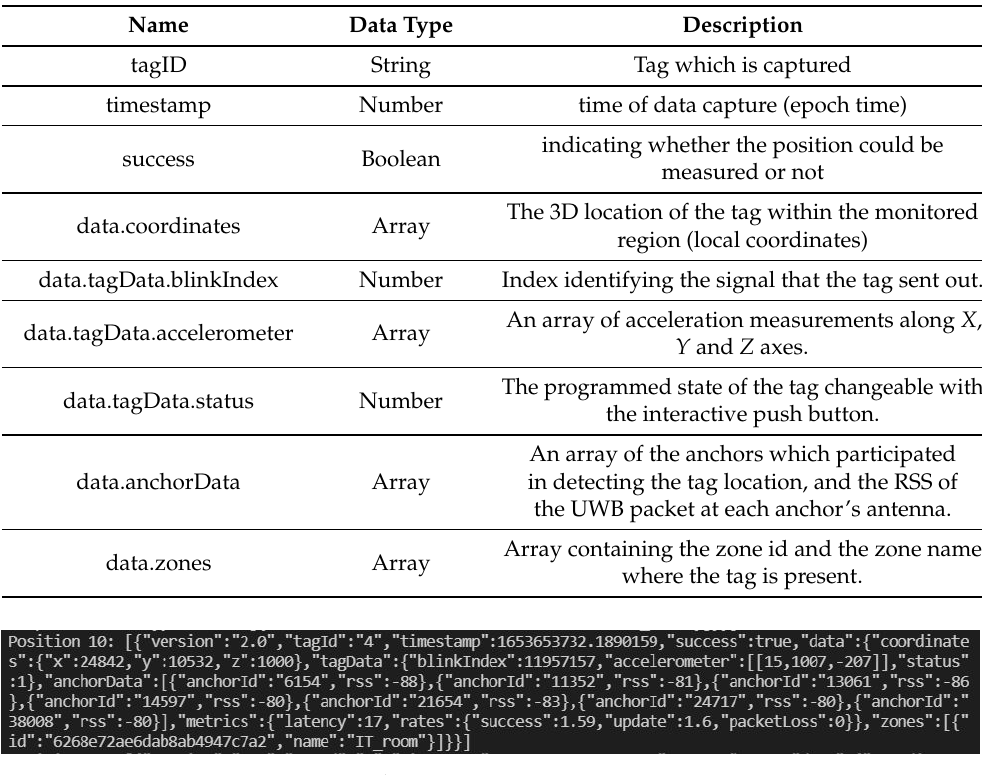
Table 2. MQTT message structure.